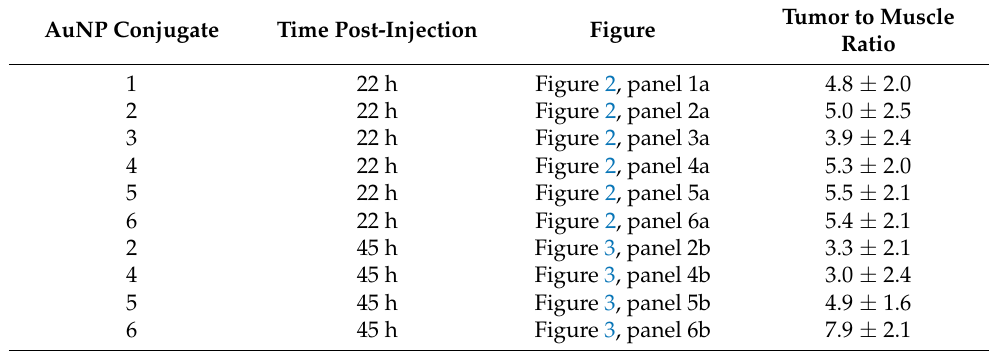
Table 3. Tumor to muscle ratios of gold nanoparticle conjugates.